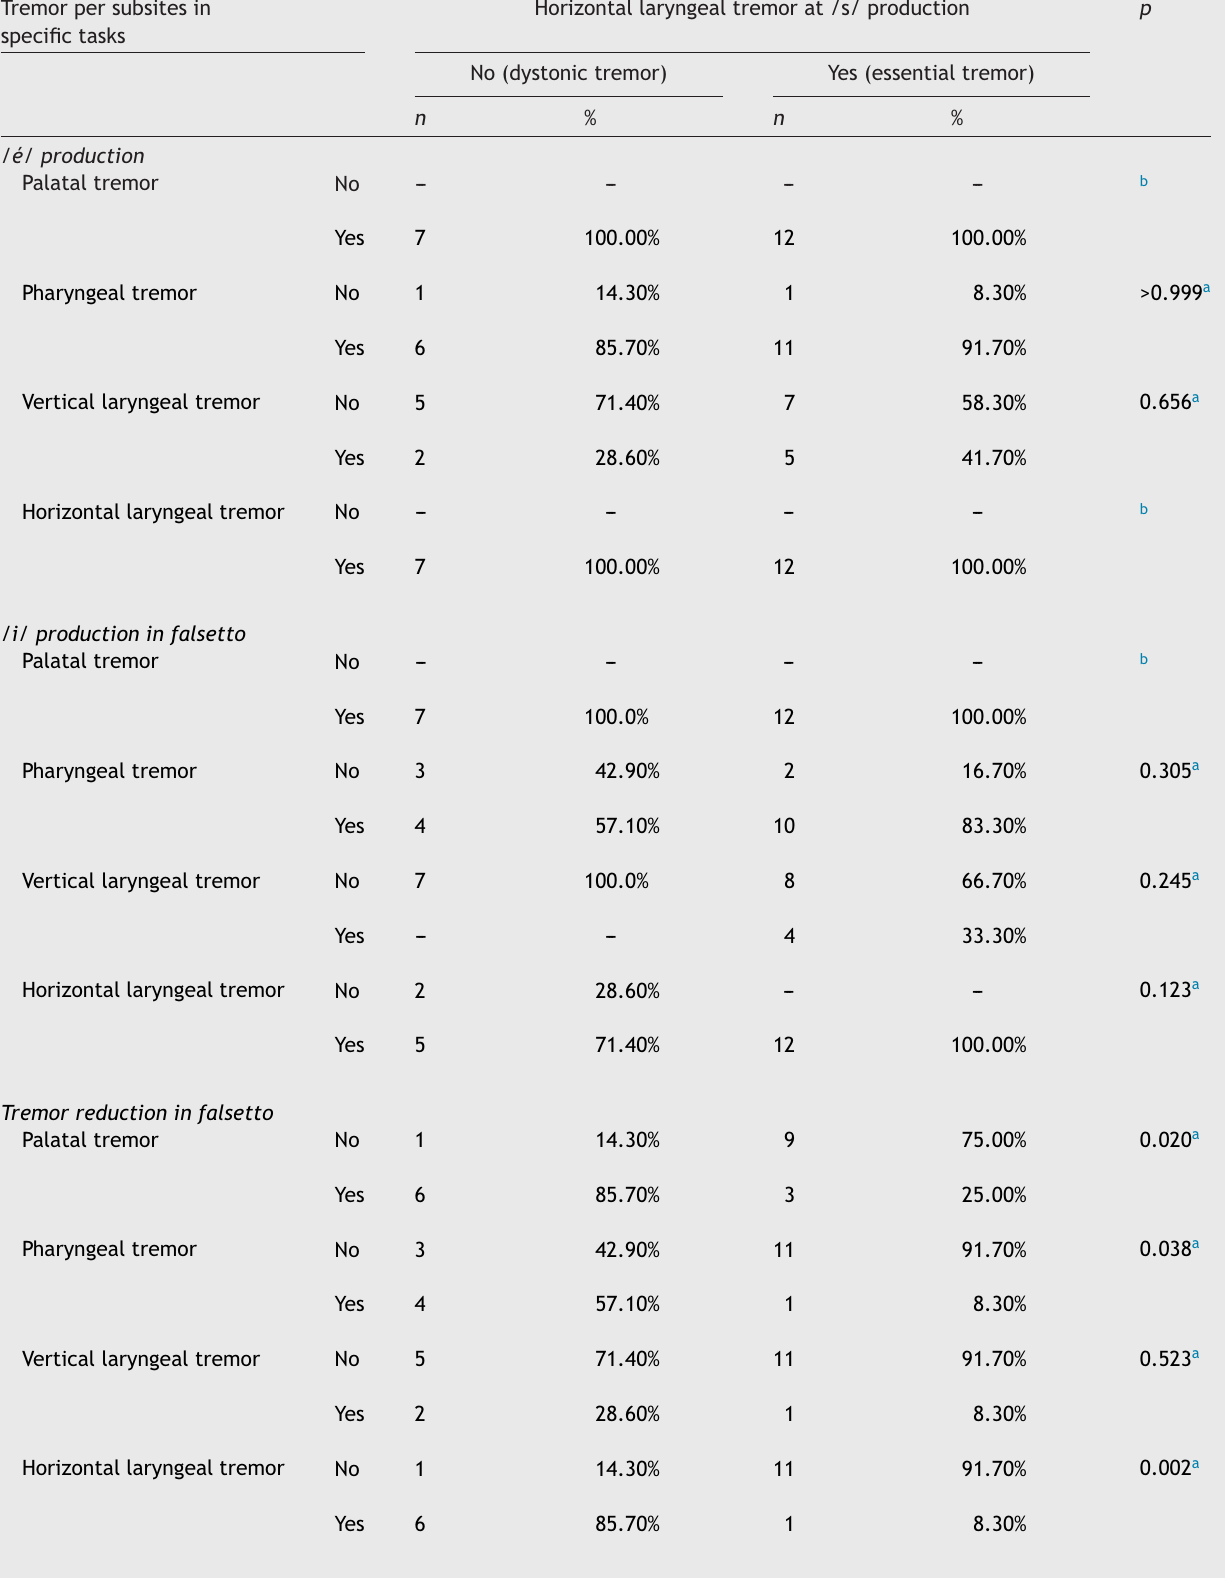
Horizontal laryngeal tremor at /s/